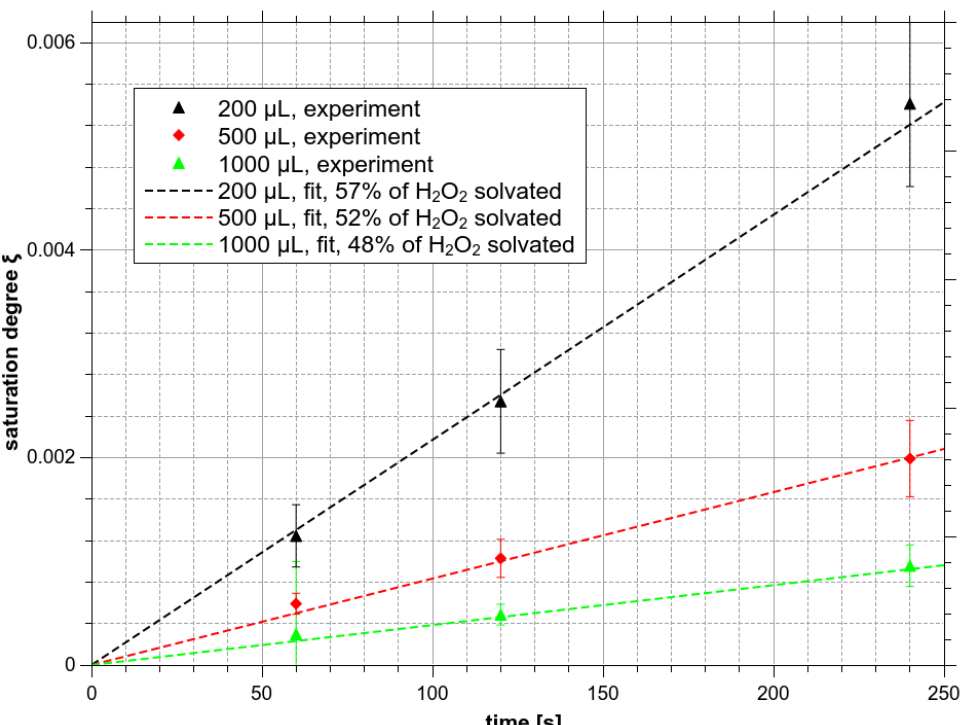
Figure 9. Saturation degree ξ H2O2 of H 2 O 2 as a function of treatment time and bulk water volume. In reality, not all of the H 2 O 2 molecules passing through the reactor can be dissolved.